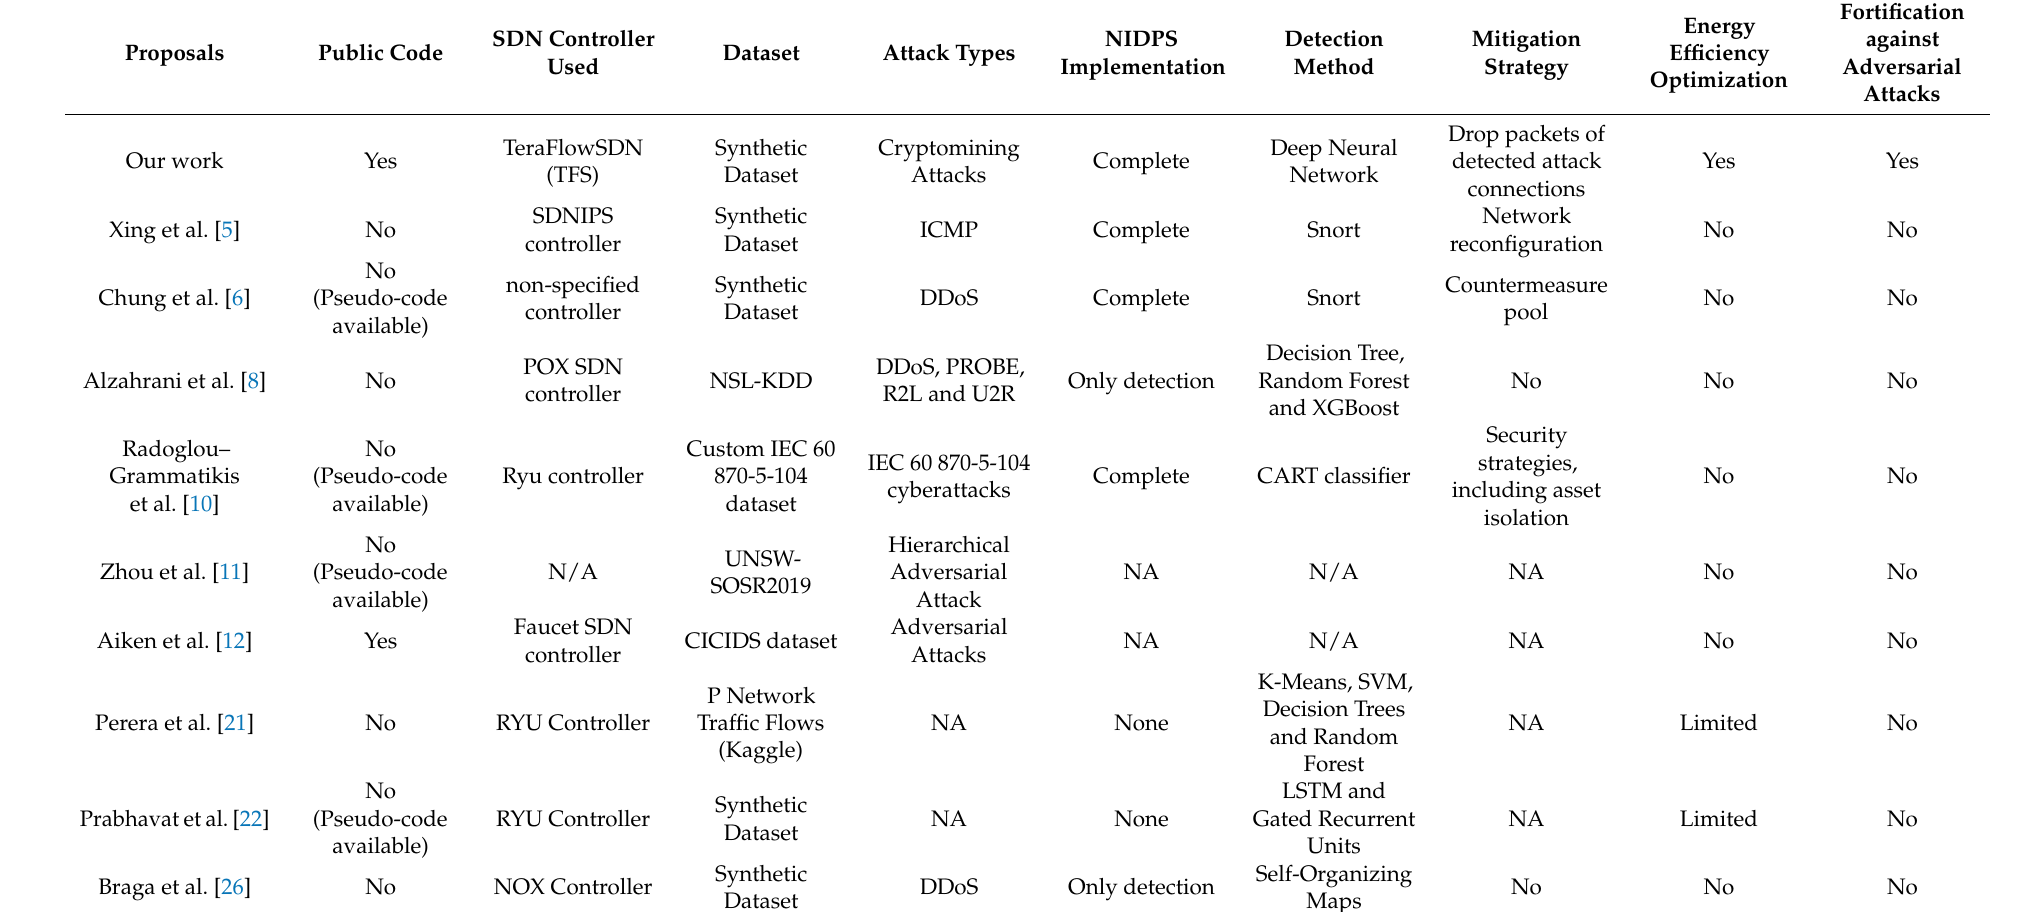
Table 1. Comparative analysis of the contributions of the proposals related to our